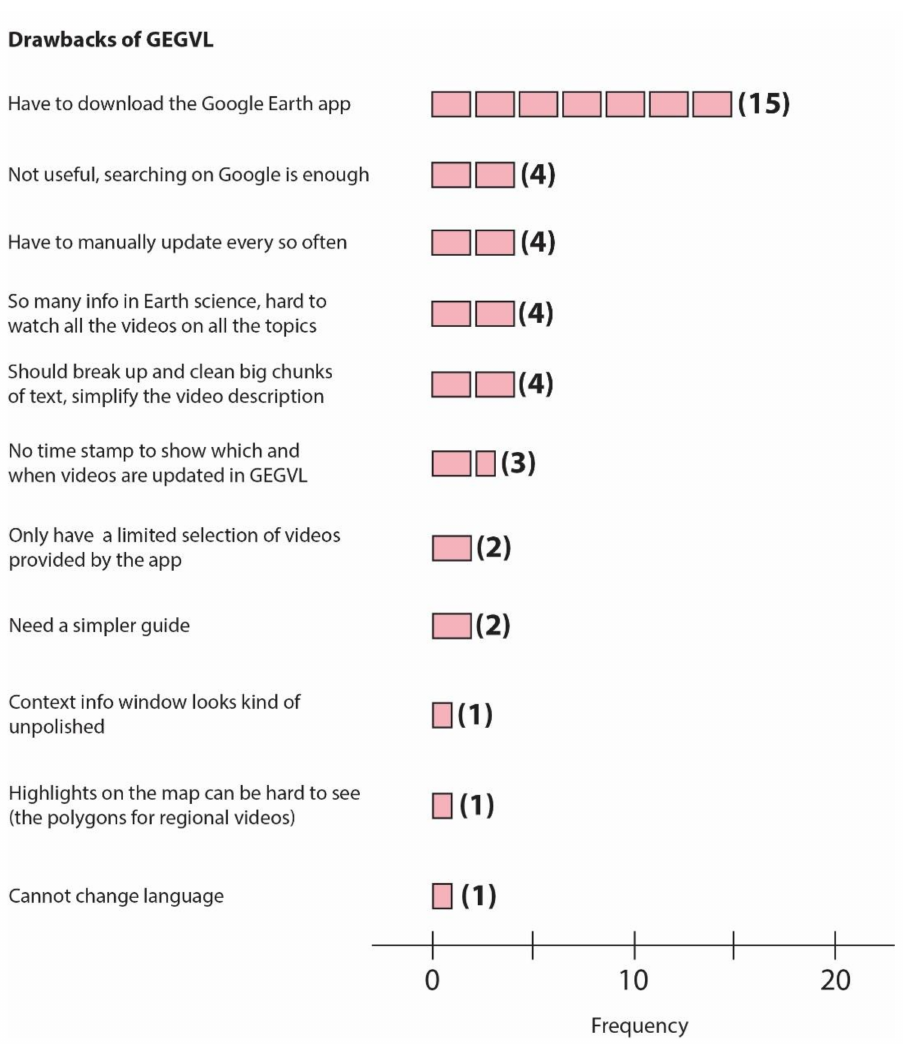
Figure 6. Reasons for not liking